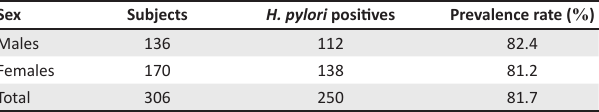
TABLE 1: The prevalence of Helicobacter pylori according to gender distribution of the study subjects.